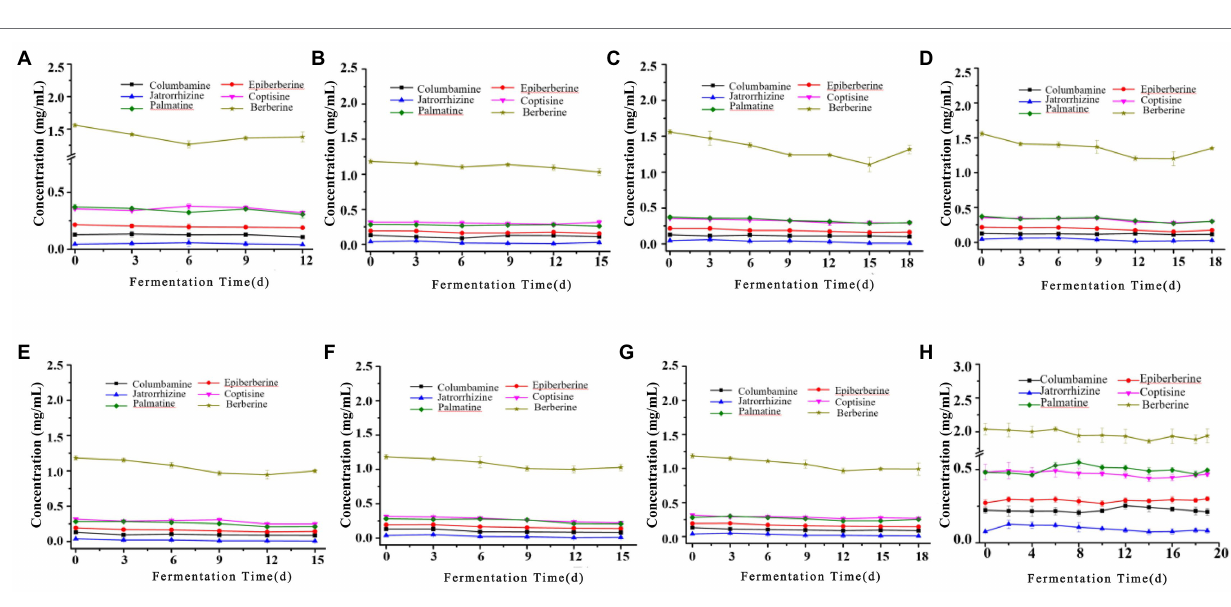
FIGURE 7 | Content of alkaloids during fermentation of LZF by monoculture fermentation and natural fermentation. (A) Penicillium expansum YY-46; (B) P. qlabrum YY-51; (C) A. niger YY-9; (D) A. japonicus YY-5; (E) C. oxysporum YY-19; (F) C. tenuissimum YY-23; (G) C. cladosporioides YY-34; and (H) natural